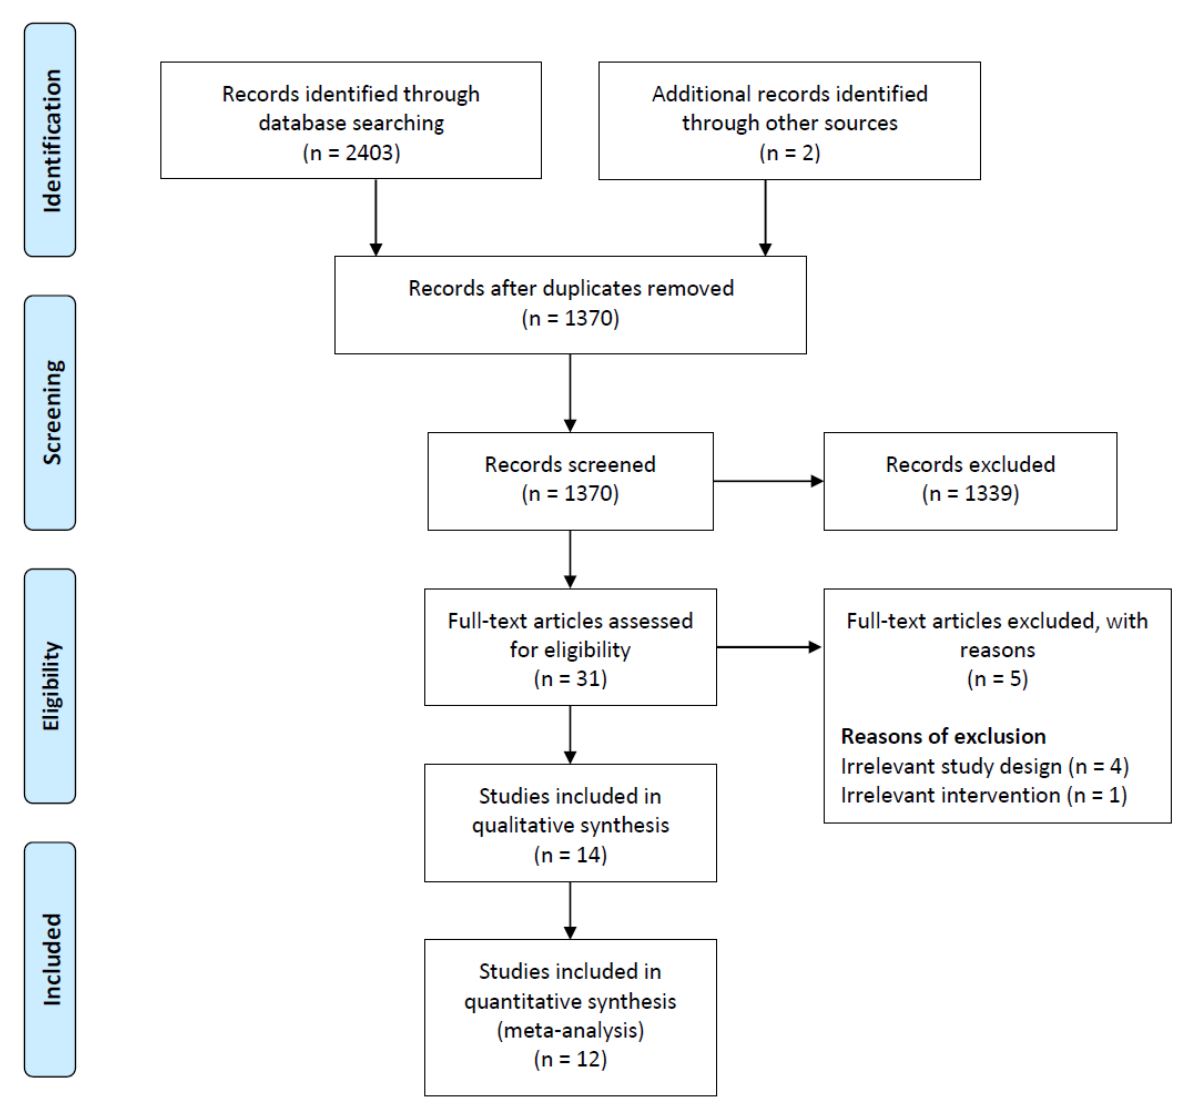
Figure 1. Prisma flow chart of this study .